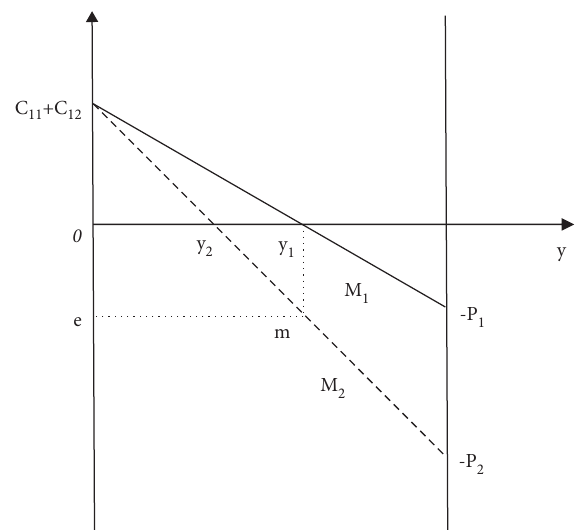
Figure 6: Analysis of the mixed strategy